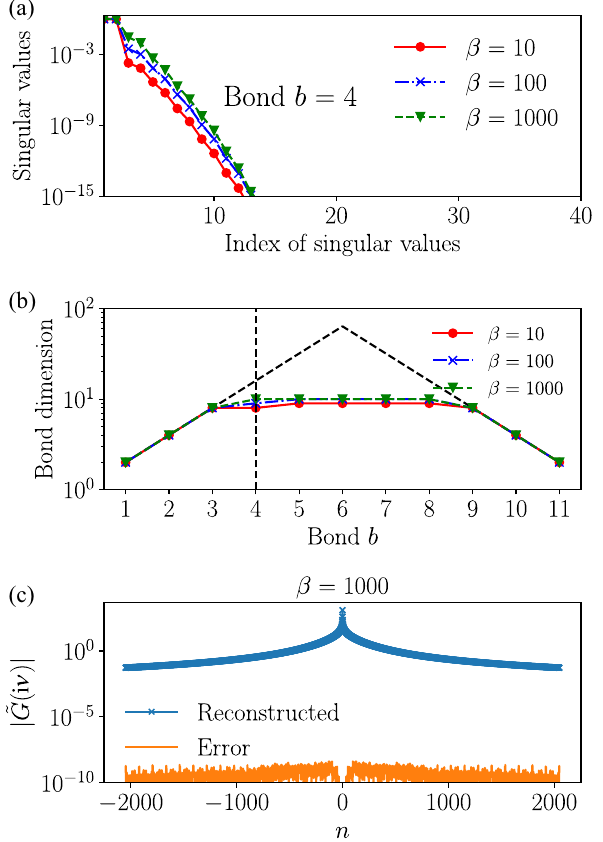
˜ G ð i ν Þ for the same model as in Fig. 6 FIG. 8. Compression of with R ¼ 12 . Note that the tail is subtracted from the data before the compression. (a) Singular values at b ¼ 4 , (b) bond dimen- sions, (c) comparison between the exact and reconstructed data. In (b), the dashed line indicates the maximum bond dimensions in maximally entangled